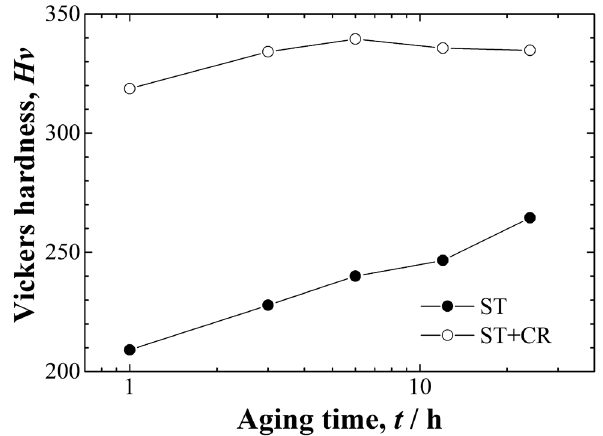
Fig. 1: Variations in the Vickers hardness of ST and ST + CR specimens aged at 723 K.